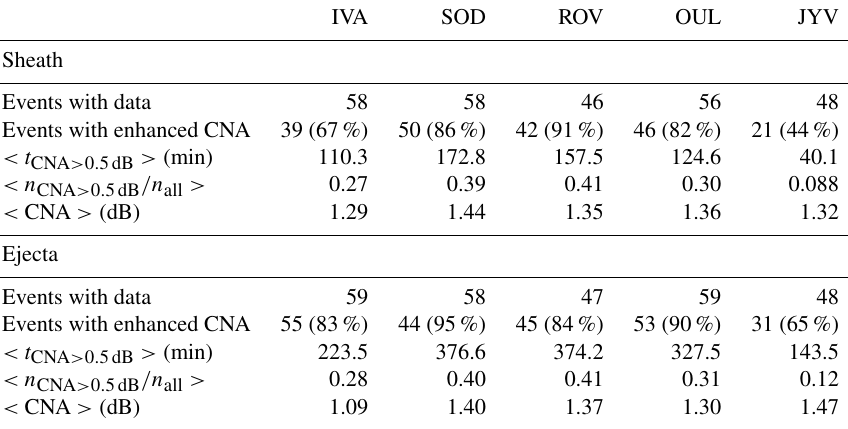
Table 2. The first two columns give the number of sheaths and ejecta for which CNA data were available and for which enhanced CNA (CNA > 0 . 5dB) occurred (the percentage of the events with enhanced CNA from the events for which data were available is shown in parentheses). The next columns give the mean time when enhanced CNA was observed (in minutes), the mean relative occurrence of enhanced CNA (defined as the ratio of samples n with enhanced CNA to all samples), and the mean magnitude of CNA (considering only values > 0 . 5dB). The total number of events analysed is